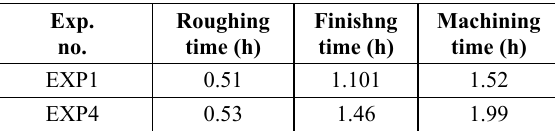
Table 5. Roughing and finishing time for machining strategies in the second phase of experimental research Exp.